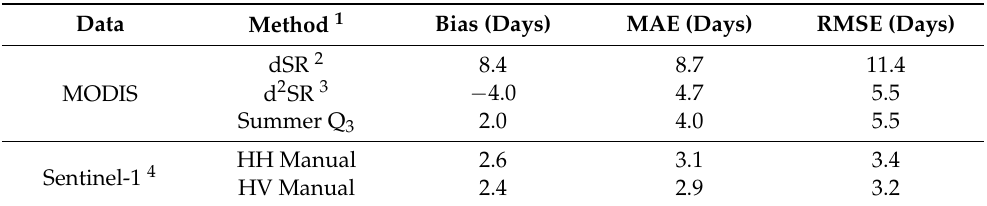
Table 3. Agreement between manual BUE dates from water temperature dynamics (the “WTemp Manual” method) and other BUE estimation methods ( n = 16).